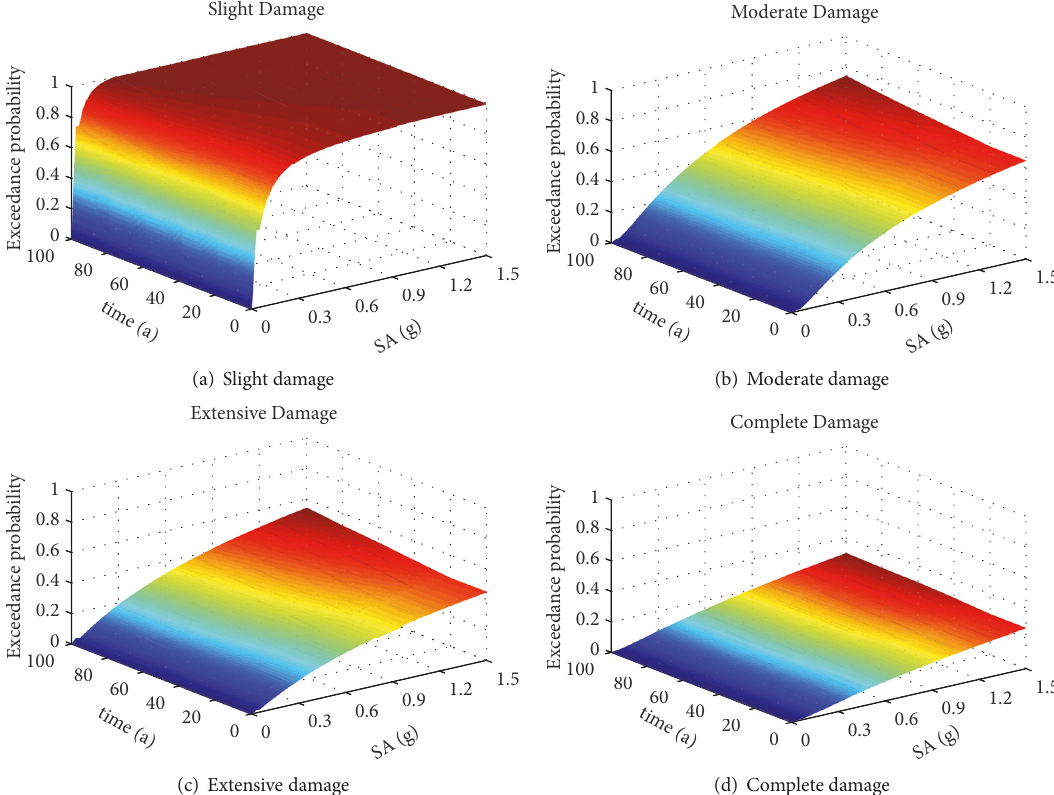
Figure 18: The vulnerability surfaces of 3 # bearing under different damage